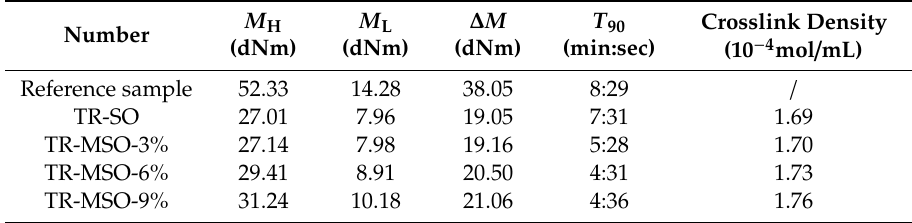
( b ) Figure 5. Mooney viscosity ( a ) and G′-strain curves ( b ) of tread rubber with different amounts of plasticizer.